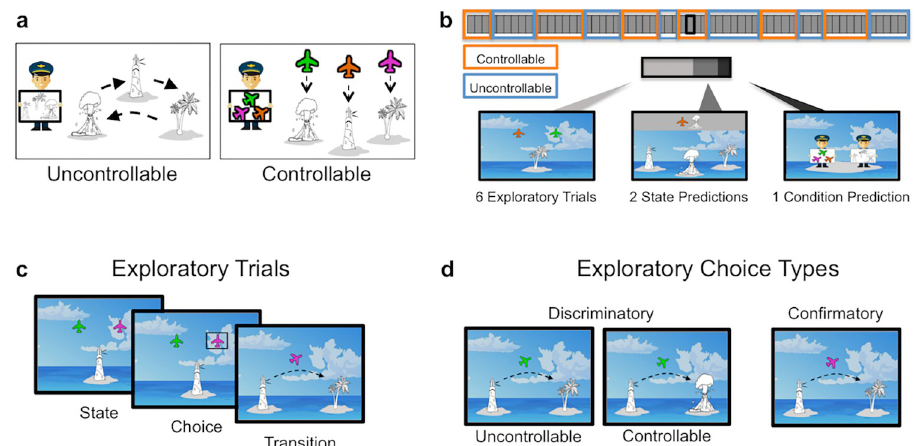
Fig 1. Task Design. (a) Two pilots fly participants around a set of islands. In the controllable condition, the pilot flies to an island based on the color of the plane that the participant selected, allowing participants’ choices to influence the subsequent state. In the uncontrollable condition the pilot flies in a particular route without considering the plane that the participant selected. (b) A schematic of the task is shown. The controllable and uncontrollable conditions of the task alternate covertly. After every six exploratory trials, participants are probed about the subsequent state (“Where is the plane most likely to fly next?”) and the condition (“Which pilot was flying the plane?”). (c) On every exploratory trial, participants see the current island and two planes. They can choose one plane to see where it will fly. (d) Participants can use their knowledge of the transition structure during the exploratory trials to select choices that reveal which pilot is flying the plane. Only discriminatory choices can be used to disentangle the current condition.